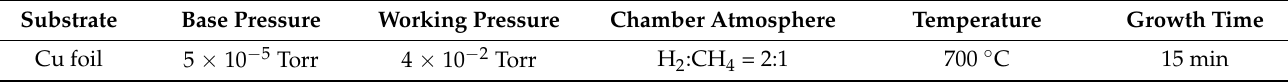
Table 1. The conditions of growing CNW via